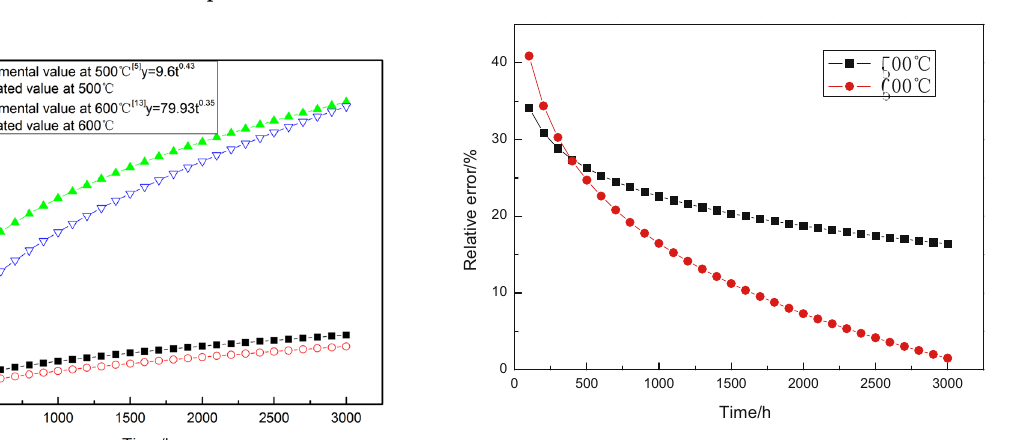
Figure 3: Simulation results and experiment results of oxidation weight gain of HCM12A in supercritical water at 500 and 600°C.